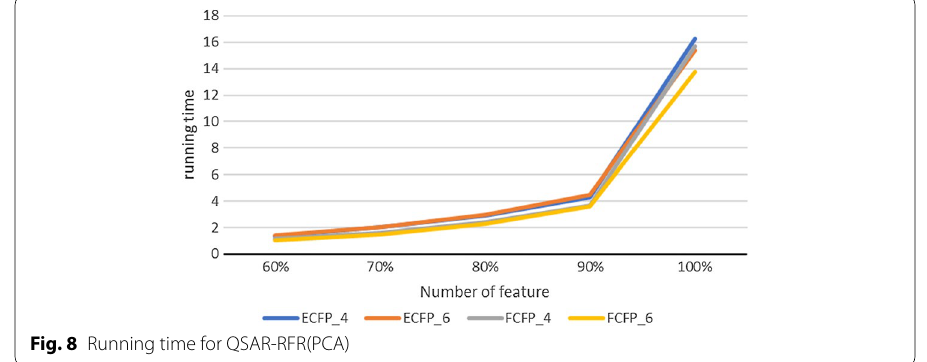
Fig. 8 Running time for QSAR-RFR(PCA)